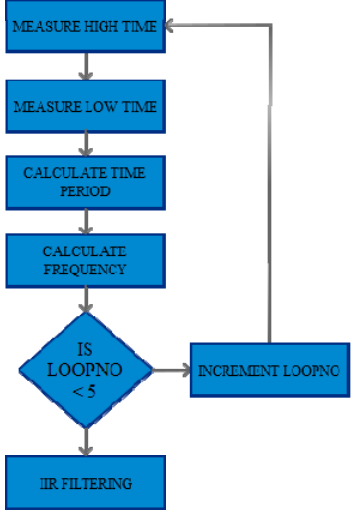
Figure 9. Block diagram of critical level loop.